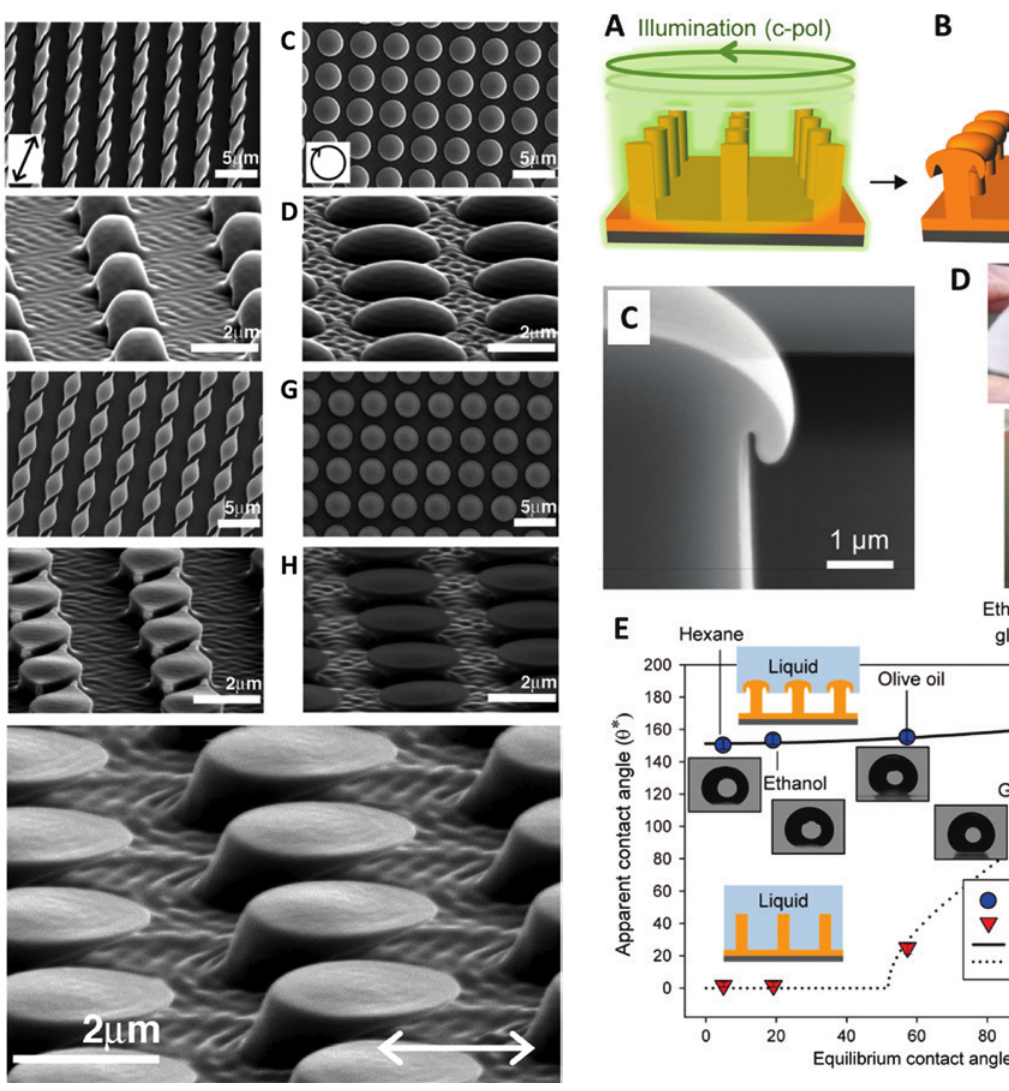
Figure 18: Azopolymer microstructures obtained from the irradia- tion of an array of cylindrical microposts in different configurations.